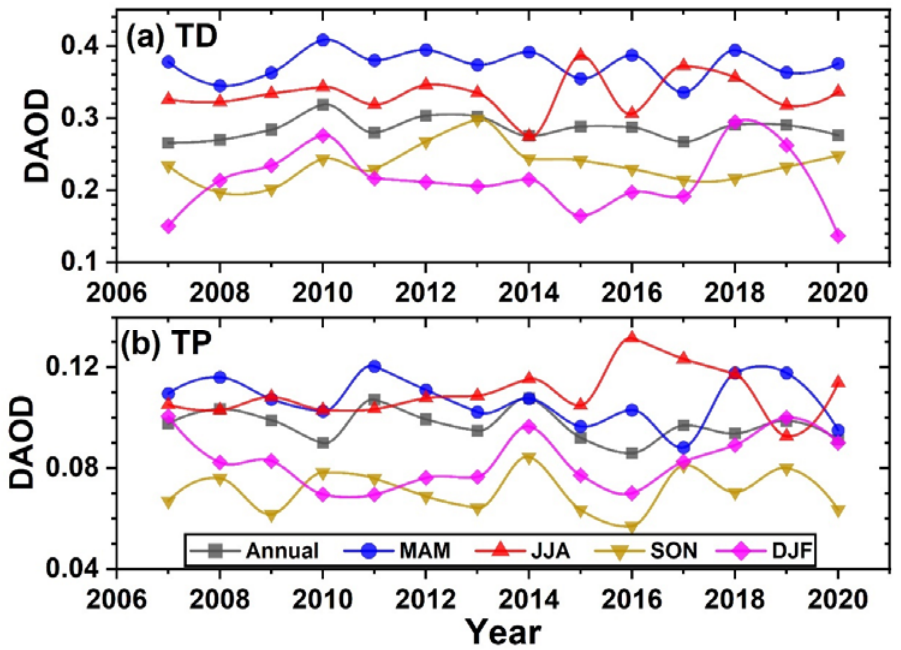
Figure 3. Variations of annual and seasonal DAODs over ( a ) TD and ( b )TP.